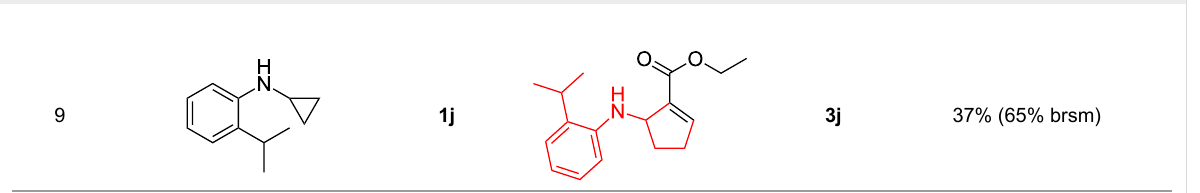
Table 2: Substrate scope of N -arylaminocyclopropanes a . (continued)